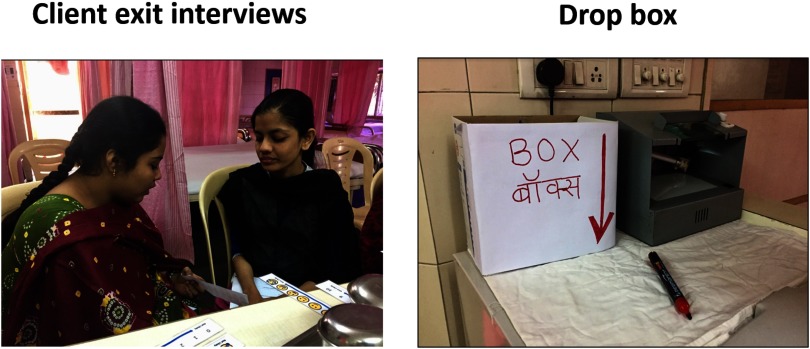
Two Net Promoter Score Implementation Approaches Tested in India